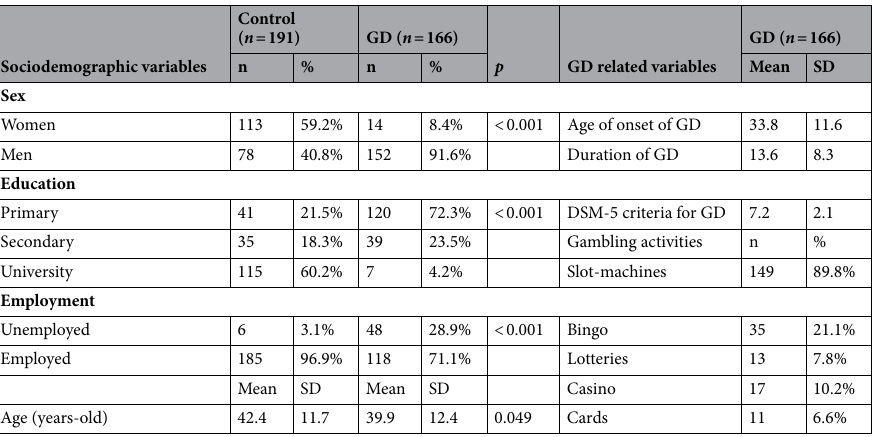
Table 2. Description of the samples. SD standard